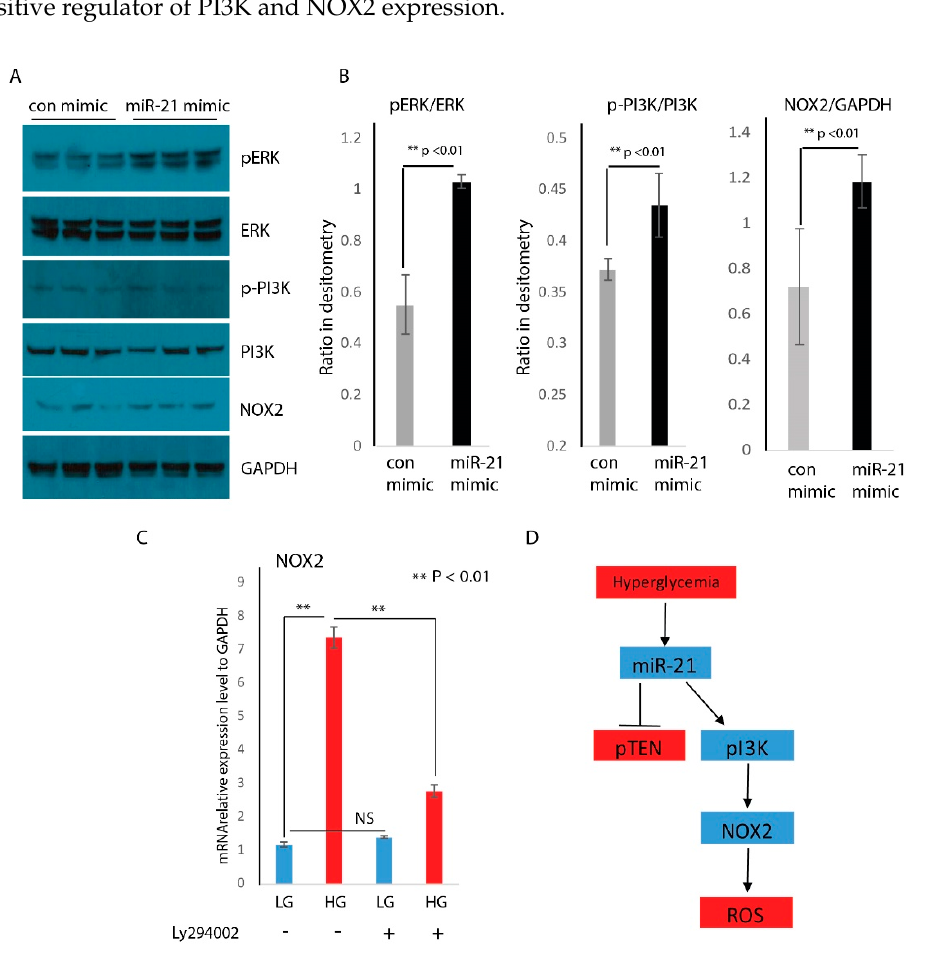
Figure 6. NOX2 is induced by hyperglycemia, and its induction is dependent on the PI3K pathway. ( A ) Western blot analysis of pERK, ERK, pPI3K, PI3K, and NOX2 following transfection of RAW macrophages with miR-21 mimic or control mimic. GAPDH served as internal loading control; ( B ) quantification of relative intensities for the ratio of pERK / ERK, pPI3K / PI3K, and NOX2 / GAPDH from Western blot; ( C ) real-time PCR analysis indicated that NOX2 mRNA abundance was induced by hyperglycemia and attenuated by Ly294002 treatment to inhibit the PI3K pathway (mean + SD, n = 3 per group, ** p < 0.01); ( D ) proposed model of miR-21 and its induction of NOX2 and ROS production.